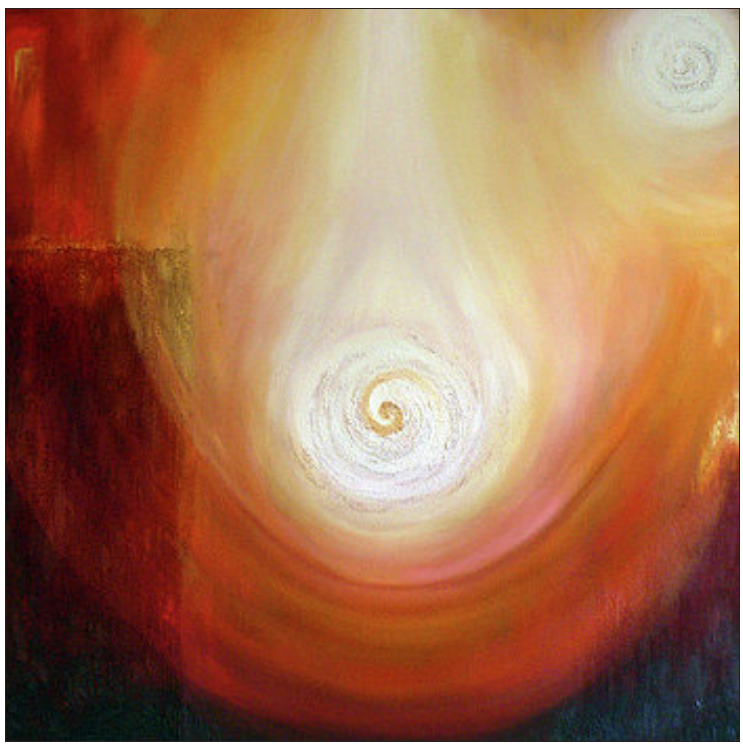
Figure 1: Alexandra Florschutz , Womb of the world , 2011, oil and mix media on canvas, private collection Source: Florschutz,